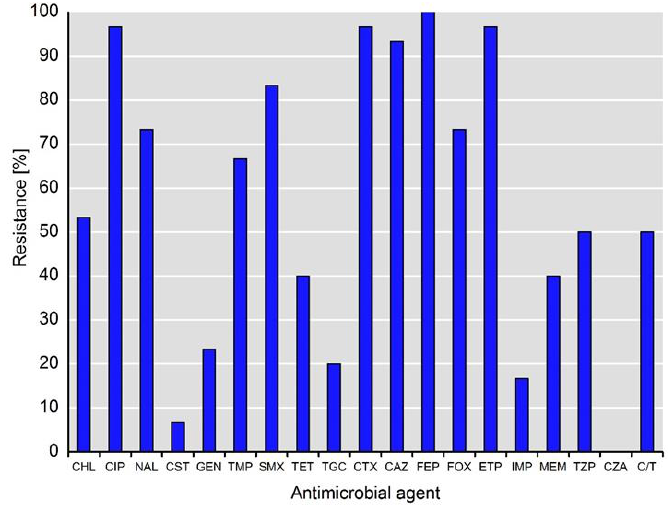
Figure 1. Phenotypical resistance to antimicrobial agents detected among isolates of Klebsiella spp. ( n = 30). Abbreviations for antimicrobial agents: CHL, chloramphenicol; CIP, ciprofloxacin; NAL, nalidixic acid; CST, colistin; GEN, gentamicin; TMP, trimethoprim; SMX, sulfamethoxazole;